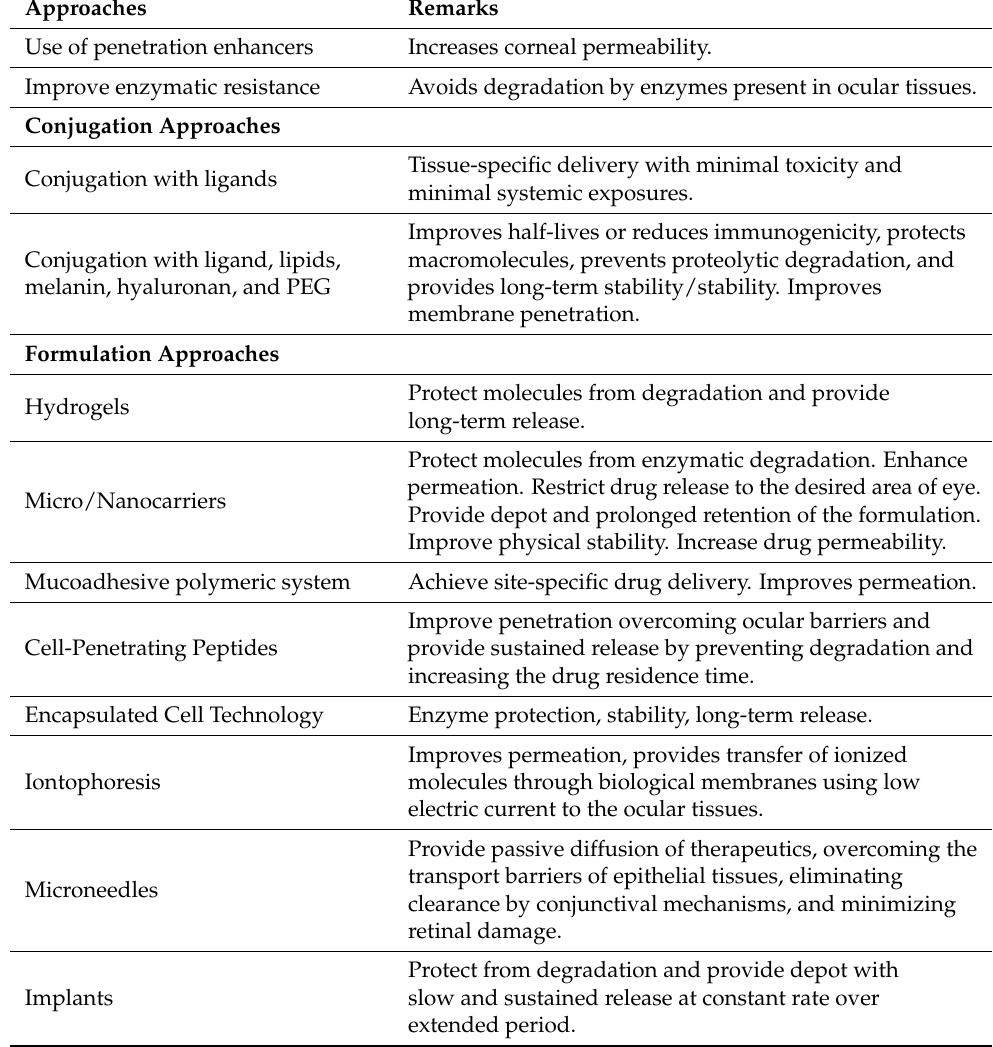
Table 2. Examples of different approaches used to improve the bioavailability of ocular therapeu- tic